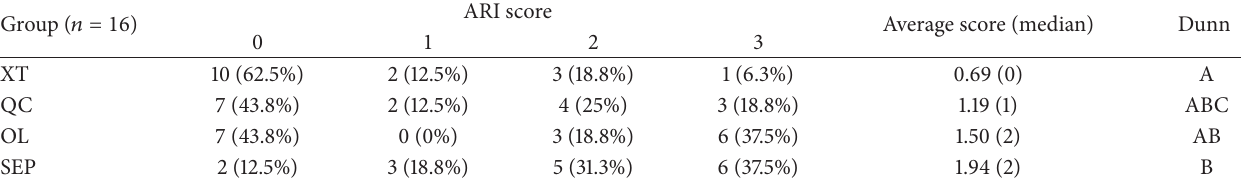
Table 4: Adhesive remnant scores (ARI) of the four groups [ 𝑛 (%)], average score, median, and statistical difference found.